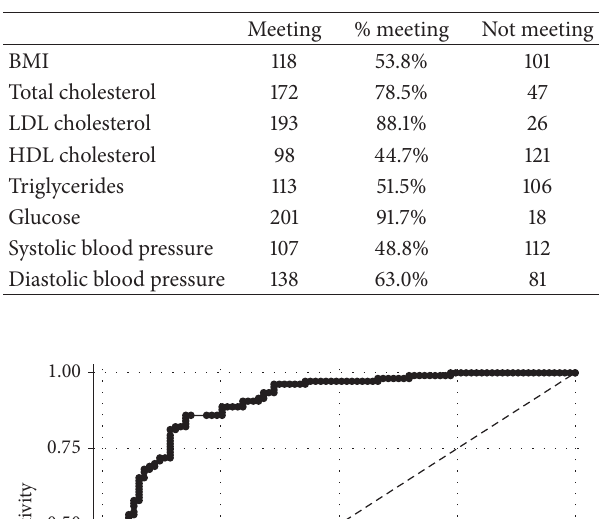
Table 2: Number of children meeting standards/recommendations for each measure (expressed as counts and percentages).